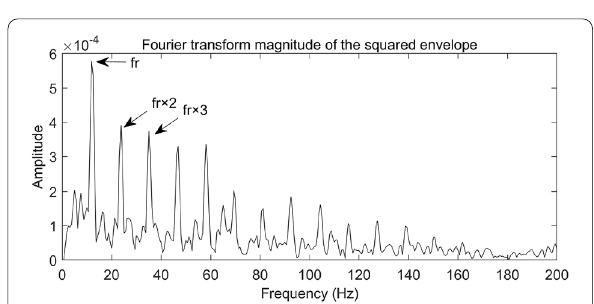
Figure 28 The squared envelope spectrum of the processed signal based on the proposed